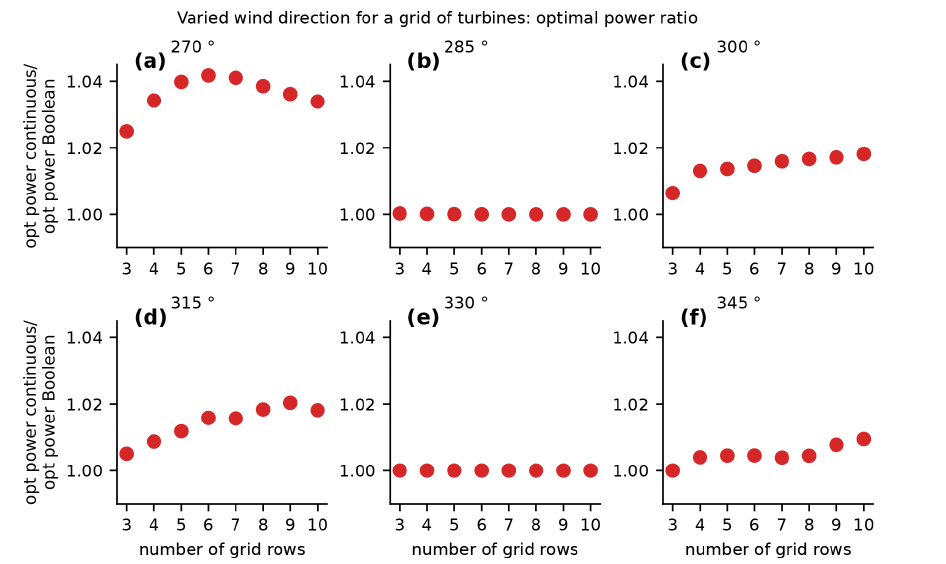
Figure 7. Comparison of the optimal power achieved with wake steering with yaw angles optimized with a traditional continuous approach compared to our novel Boolean optimization. These results are for a grid wind plant for which, within each panel, the x axis indicates different numbers of rows in the power plant. Each panel shows results for a different wind